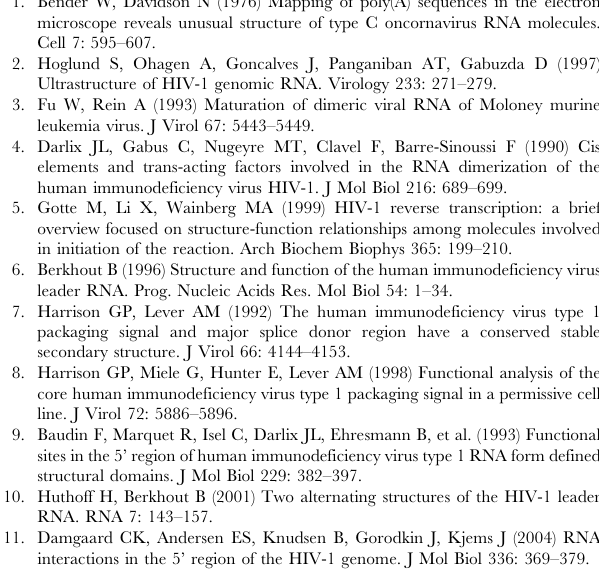
Figure S1 Melting profiles of PNA with corresponding RNA and DNA duplexes. Panel A . A1 : UV absorbance of PNA 73 with antiparallel RNA, A2 corresponding first derivative, A3 UV absorbance of PNA 73 with antiparallel DNA, A4 corresponding first derivative. Panel B . B1 : UV absorbance of PNA 98 with antiparallel RNA, B2 corresponding first derivative, B3 UV absorbance of PNA 98 with with antiparallel DNA, B4 corresponding first derivative. Panel C . C1 : UV absorbance of PNA 102 with antiparallel RNA, C2 corresponding first derivative, C3 UV absorbance of PNA 102 with antiparallel DNA, C4 corresponding first derivative. Panel D . D1 : UV absorbance of PNA 110 with antiparallel RNA, D2 corresponding first derivative, D3 UV absorbance of PNA 110 with antiparallel DNA, D4 corresponding first derivative. Figure S2 Melting profiles of PNA with corresponding RNA and DNA duplexes. Panel A. A1: UV absorbance of PNA 237 with antiparallel RNA, A2 corresponding first derivative, A3 UV absorbance of PNA 237 with antiparallel DNA, A4 corresponding first derivative. Panel B. B1: UV absorbance of PNA 251 with antiparallel RNA, B2 corresponding first derivative, B3 UV absorbance of PNA 251with antiparallel DNA, B4 corresponding first derivative. Panel C. C1: UV absorbance of PNA 271 with